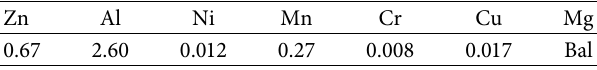
Table 1: AZ31B magnesium alloy chemical composition. Zn Al Ni Mn Cr Cu